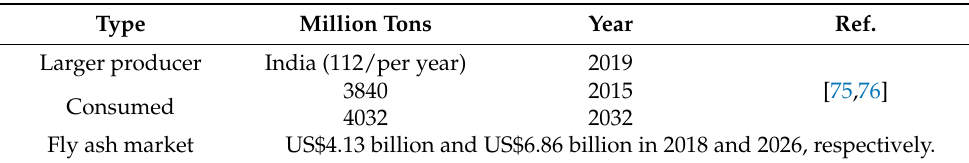
Table 4. Global production and consumption of